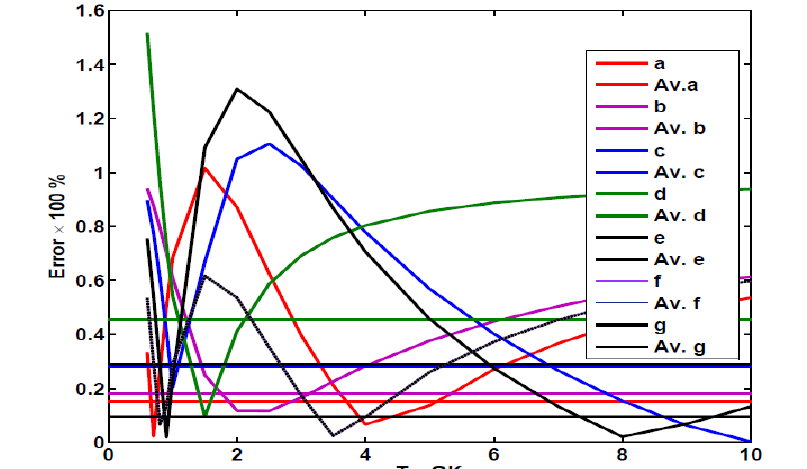
Figure 3: Relative error (curved lines) and average error (straight lines) for the difference between theoretical and calculated reaction rates for all temperature range before applying the correction from the fitting procedure. Theoretical values were taken from BRUSLIB [10]. Shown are the results taken from Table (3) for E =458 and 248.3 keV (cases 3-a to 3-h). r Temperature range was T =0.001 to 10. 9